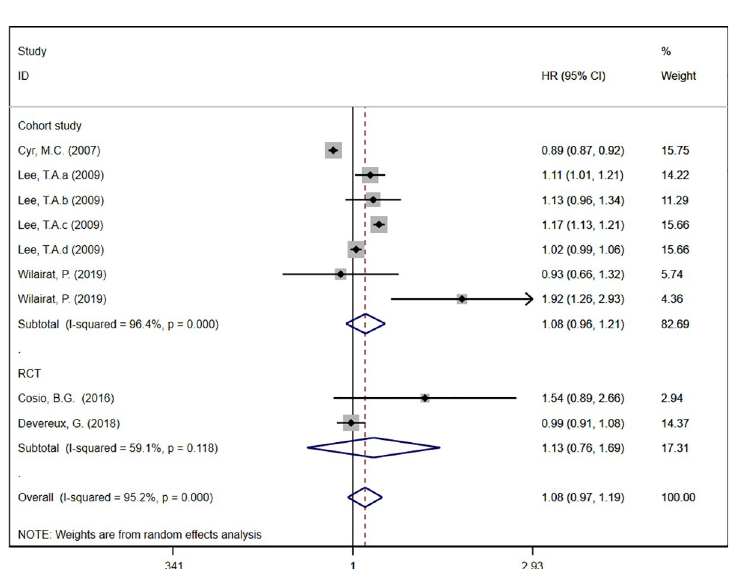
Fig 3. Forest plot of acute exacerbation rate (Subgroup analysis based on study design).